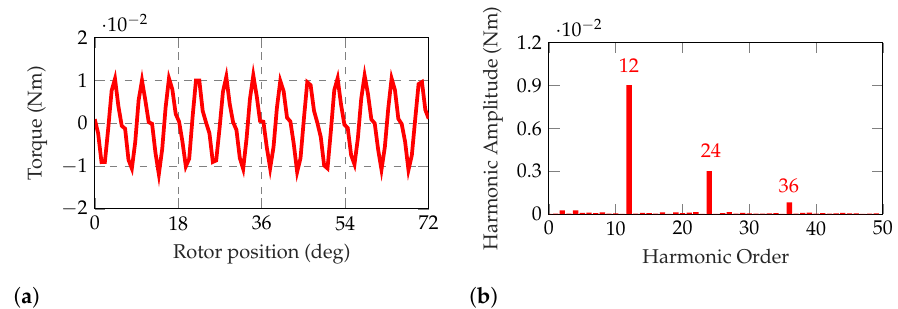
Figure 20. Cogging torque waveform and harmonic content of the 12/10 spoke PM motor. ( a ) Cog- ging torque waveform. ( b ) Harmonic content.